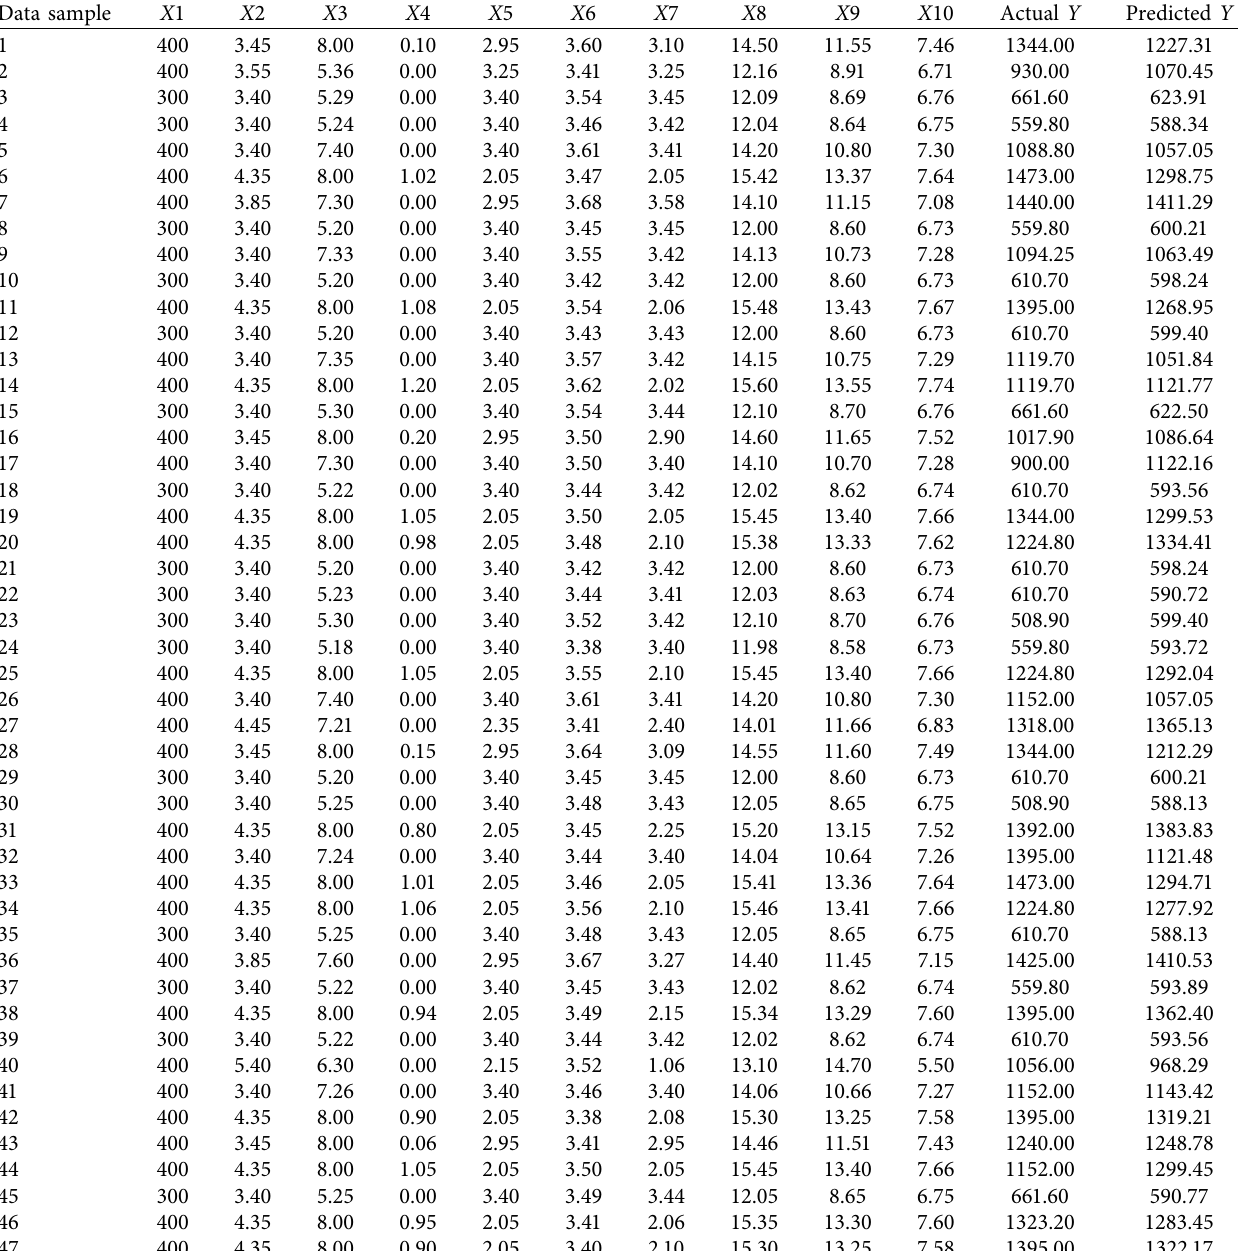
Table 2: Prediction results of a typical